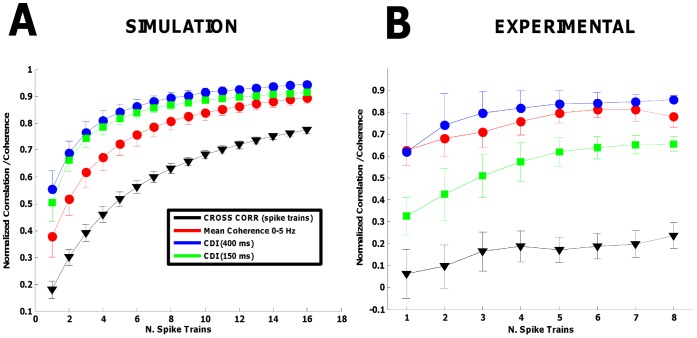
Normalized correlation values and coherence using the pooling of multiple spike trains.
A, results from the simulations using the band-pass Gaussian noise in the frequency band 0–100 Hz. B, results from the experimental recording on Subject n. 7, the one whit the highest number of motor unit spike trains correctly identified. Note a trend of saturation for all indexes when more than 4–5 motoneuronspike trains were used in the calculations.